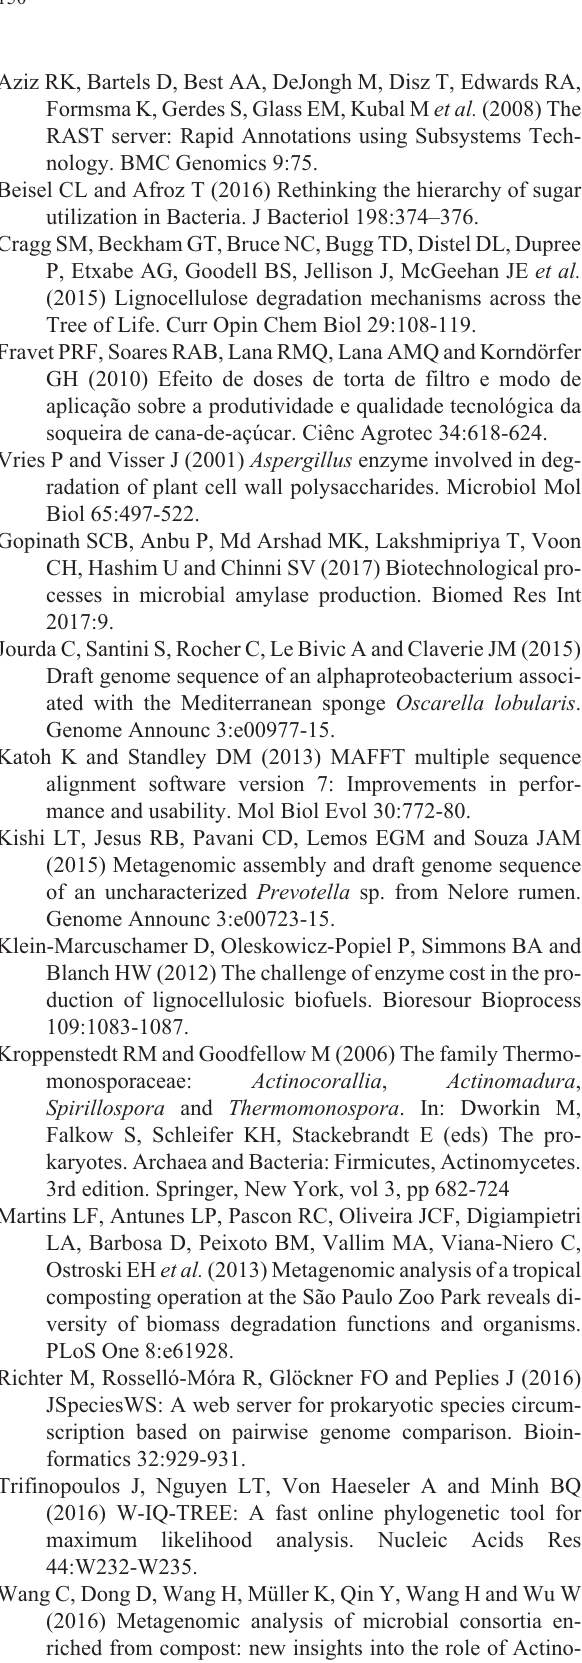
Table S2 - Comparison between the partial draft genome Table S3 - Identifications of enzymes with activity on car- bohydrate structures present in the draft genome CIT 1 re- covered from metagenomic sequencing of filter cake. Table S4 - Identifications of enzymes with activity on car- bohydrate structures present in the circular genome